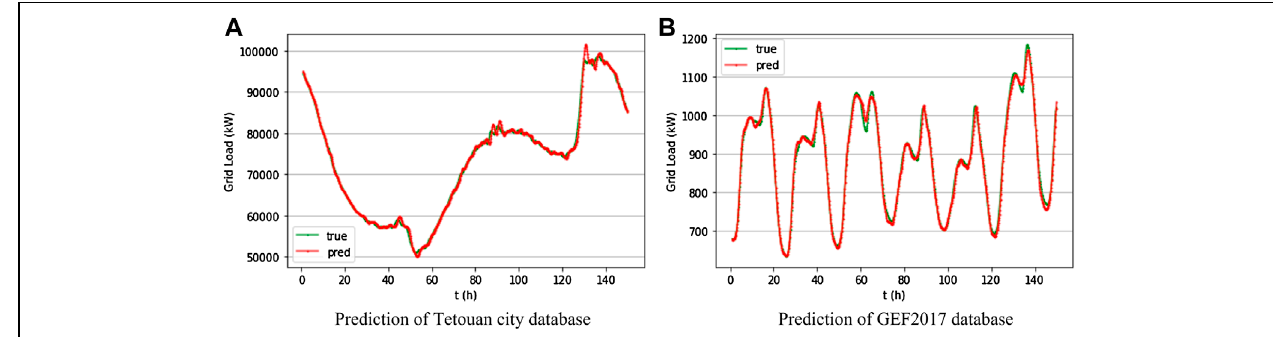
FIGURE 6 | Prediction and true load value of different databases. (A) Result of the Tetouan database. (B) Result of the GEF2017 database.